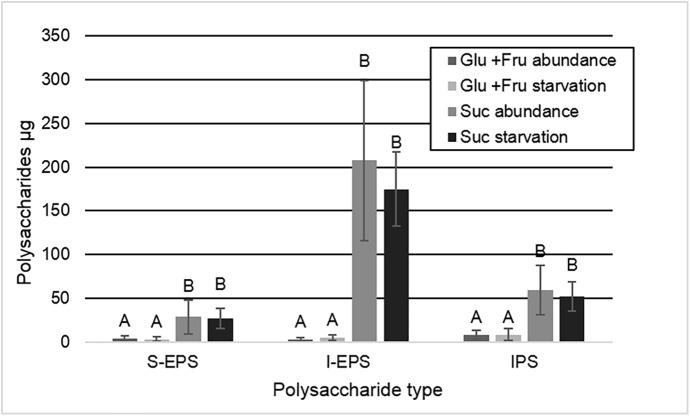
Amounts (μg) per enamel slab of extracellular polysaccharides, soluble (S-EPS) and insoluble (I-EPS), and intracellular polysaccharides (IPS) according to the treatments (glucose + fructose or sucrose) and the harvest moment (abundance or starvation).Distinct capital letters indicate significant statistically differences among groups for each polysaccharide type (p < 0.05) (Mean ± SD; n = 12).